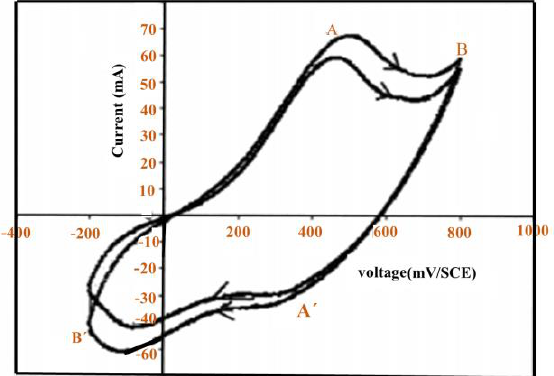
Figure 19. PANI film with potentiodynamic deposition. Reproduced from Eur. Polym. J., 125, Kumari Jangid, N.; Jadoun, S.; Kaur, N., A review on high-throughput synthesis, deposition of thin films, and properties of polyaniline, Copyright (2020), with permission from Elsevier.